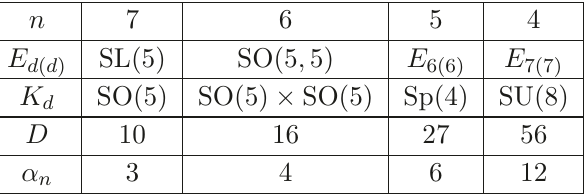
Table 2 . The U -duality groups, their maximal compact subgroups and the integers, D and α n , for various noncompact dimensions, 4